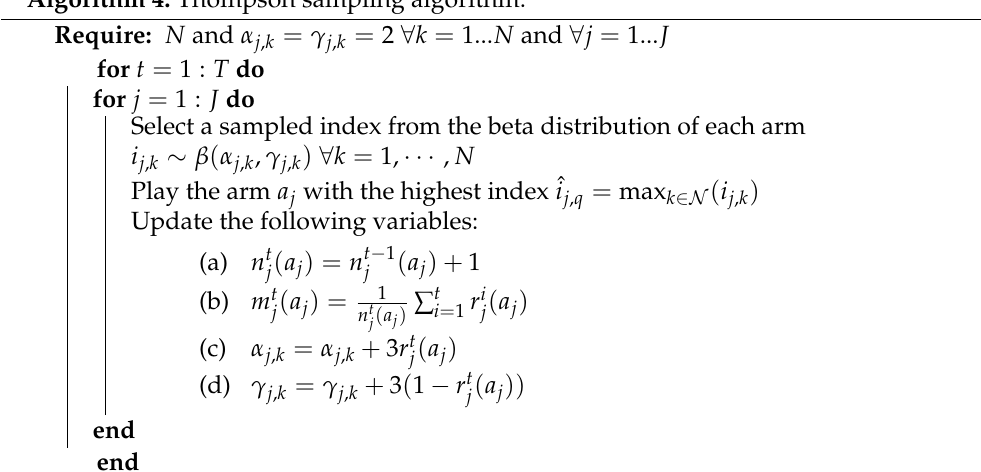
Algorithm 4: Thompson sampling